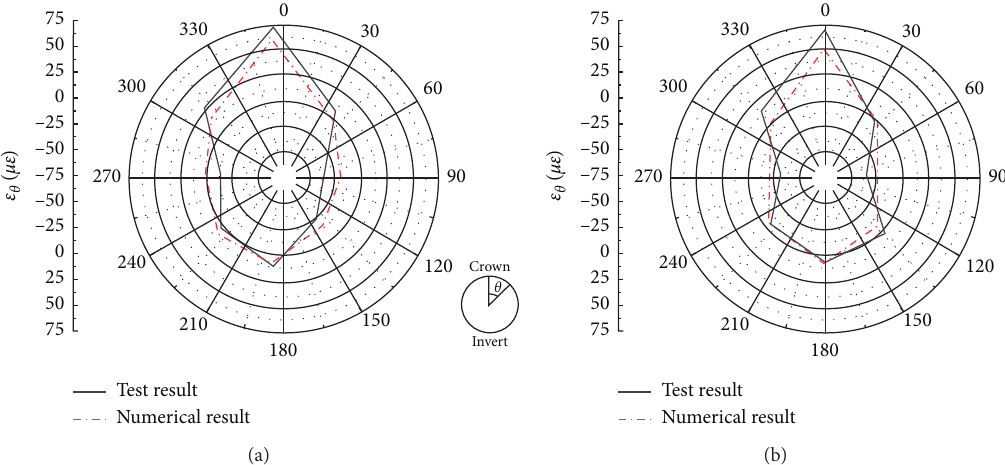
Figure 33: Comparison of the experimental and simulated circumferential strain of (a) central bell and (b) central